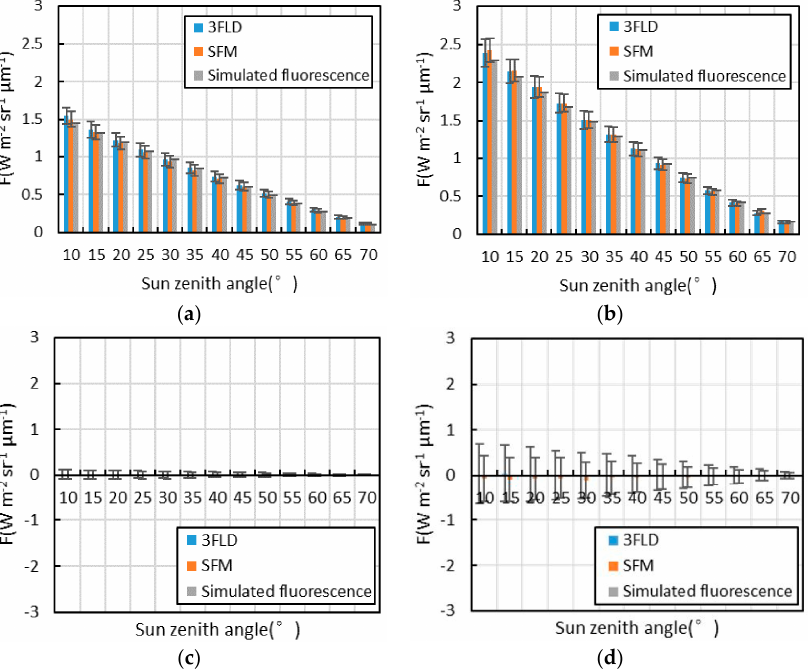
Figure 8. The fluorescence extraction results of each algorithm and the simulated value of fluorescence for data with different solar zenith angles (the rectangle in this Figure is the mean fluorescence, and the error lines is the standard deviation); ( a ) SIF of vegetation in the O 2 -A absorption band; ( b ) SIF of vegetation in the O 2 -B absorption band; ( c ) SIF of bare land in the O 2 -A absorption band; ( d ) SIF of bare land in the O 2 -B absorption